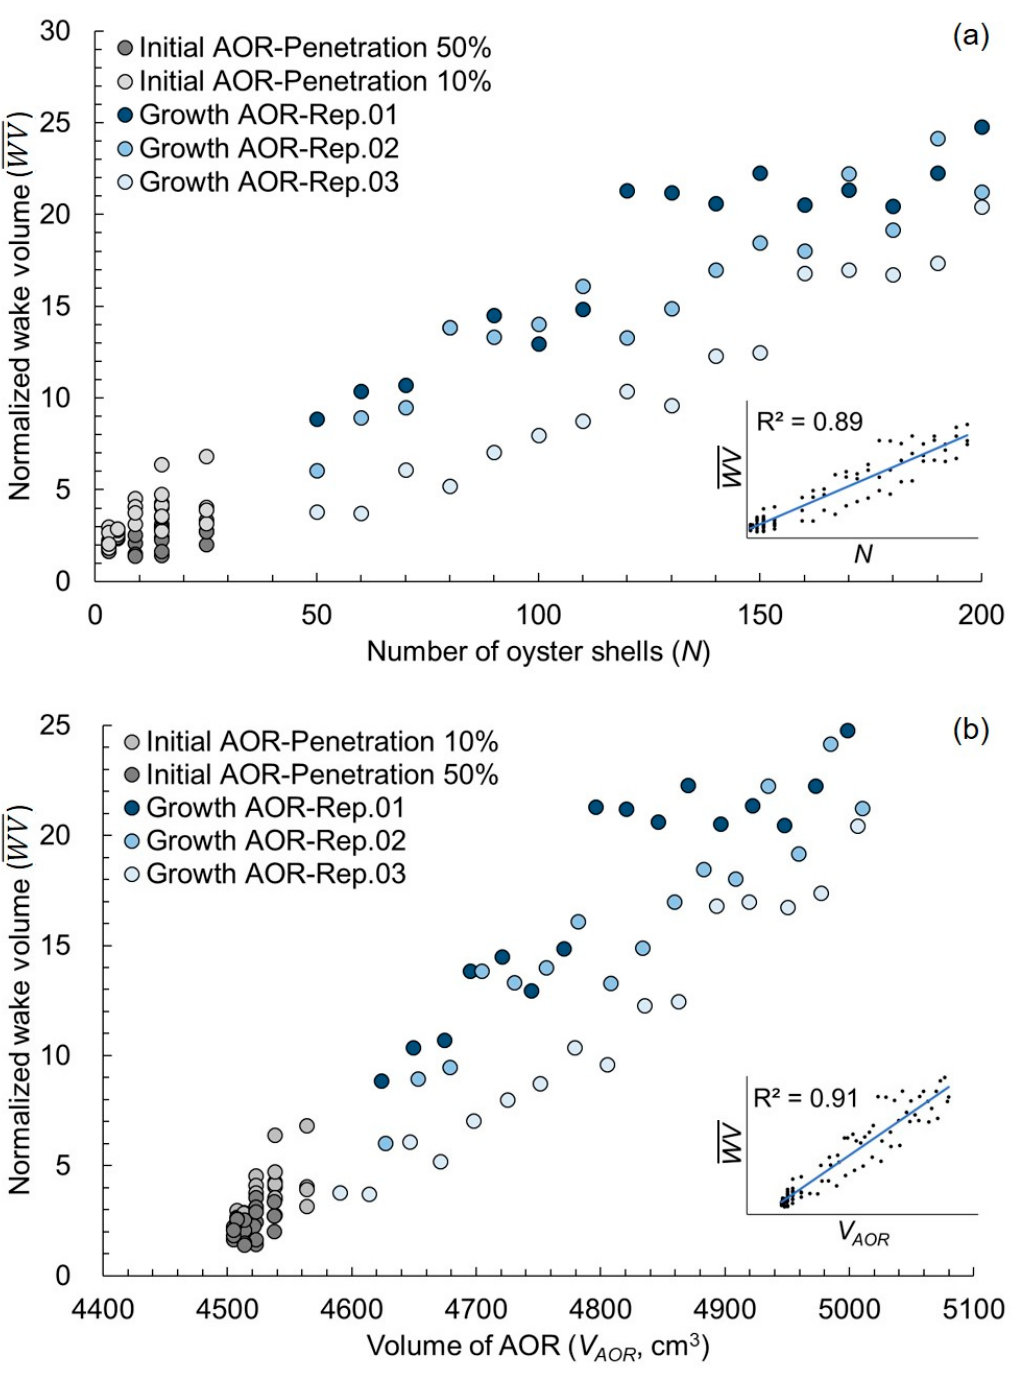
Figure 9. Normalized wake volume ( WV ) according to ( a ) the number of oyster shells ( N ) and ( b ) the structural volume of AOR ( V AOR ).